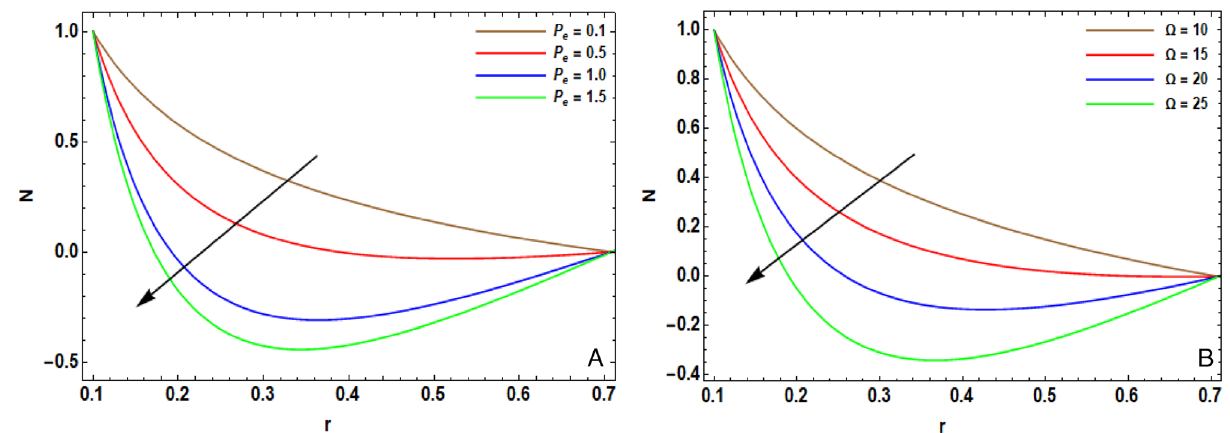
Figure 6. ( A ) Implies alteration N ( r ) for diverse amounts of P e . ( B ) implies alteration N ( r ) for diverse amounts of (cid:31)